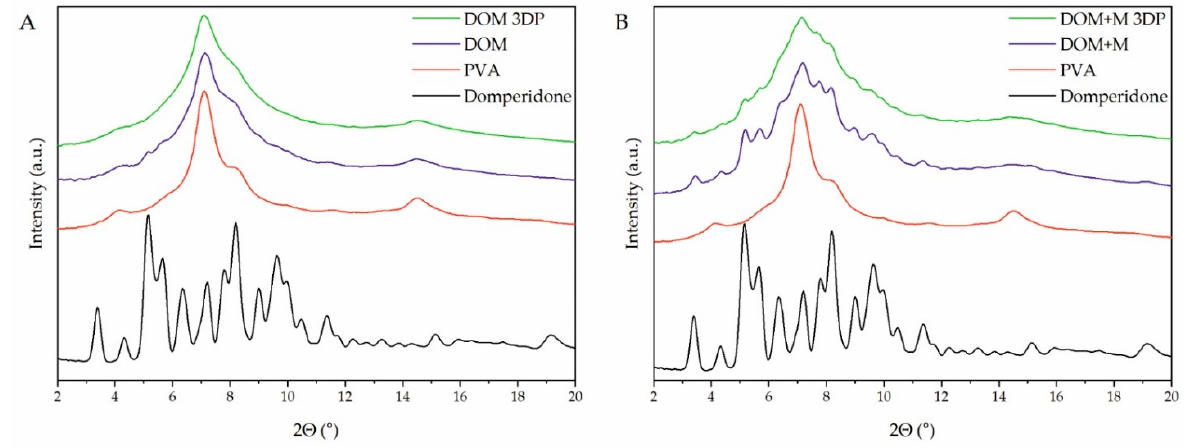
Figure 7. XRPD diffractograms of raw domperidone, DOM ( A ) and DOM + M ( B ) filaments, and 3D printed tablets made of DOM ( A ) and DOM + M ( B ) filaments.